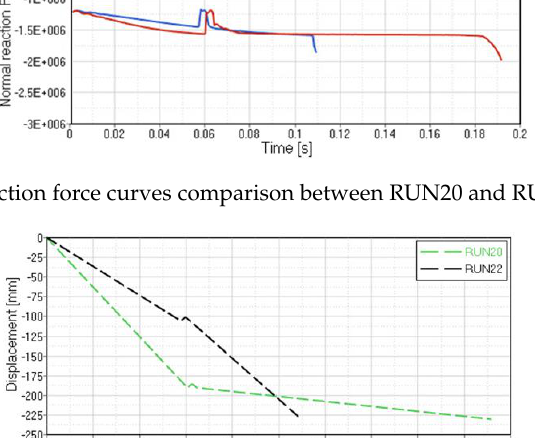
Metals 2019 , 9 , x FOR PEER REVIEW 4 of 21 Figure 10. % Thinning distribution and X1, X2, Y1 and Y2 values for the RUN20; blank0. Figure 11. % Thinning distribution and X1, X2, Y1 and Y2 values for the RUN1; blank1.